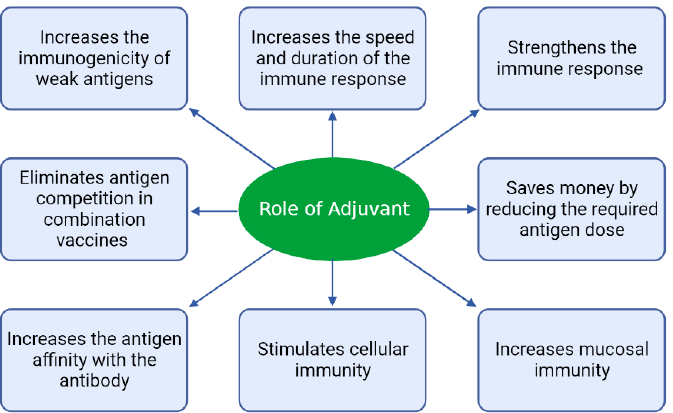
Figure 1. Different ways in which adjuvants play a role in improving immune responses in the body [1].